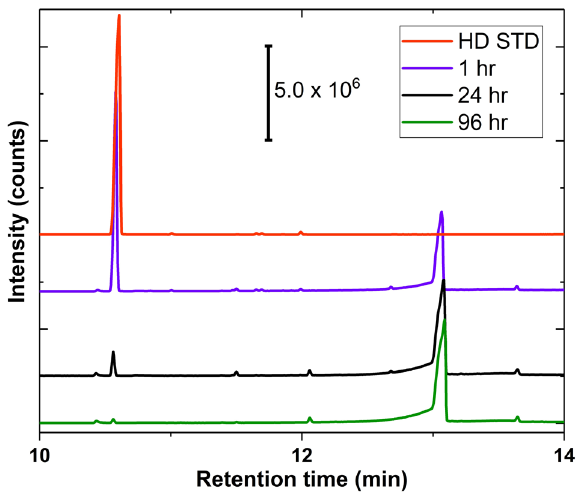
Fig. 2 GC-MS spectra of live agent HD oxidation kinetics catalyzed by SFC. Conditions: 5 μ L HD added directly to 5 mg SFC (10 turnovers based